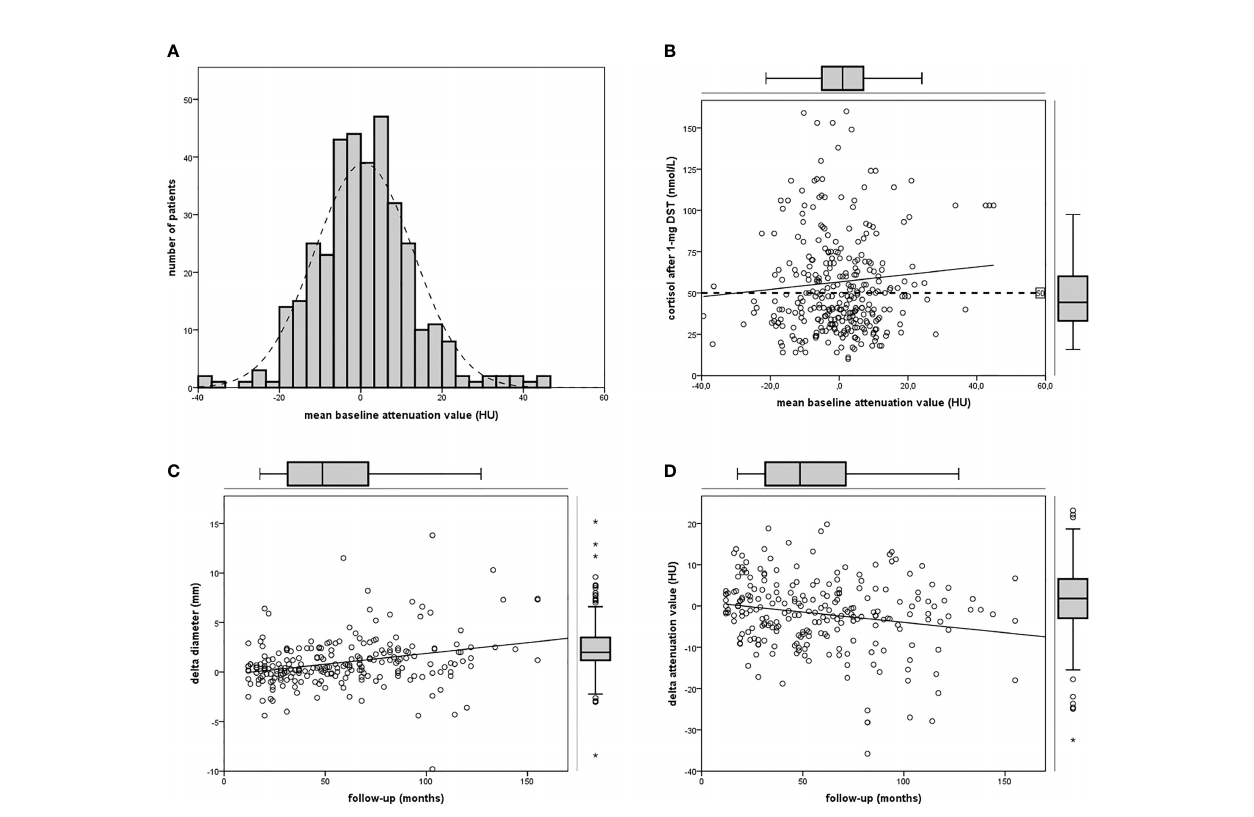
FIGURE 1 | Attenuation value in the cohort of patients. (A) Frequency histogram of mean attenuation value; (B) linear regression between attenuation value and cortisol after 1-mg DST ( n = 355); (C) linear regression between follow-up and D diameter ( n = 234); (D) linear regression between follow-up and D attenuation (pn =